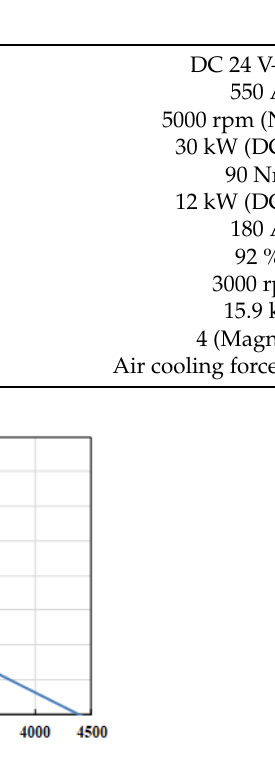
Figure 8. Relationship between motor rotational speed and torque.